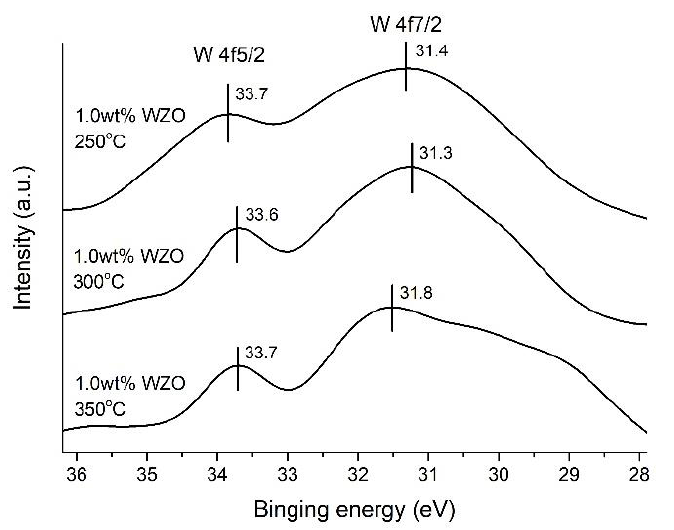
Figure 15. W 4f5/2 and W 4f/2 peak intensities of 1.0 wt.% WZO films grown at 250 °C, 300 °C, and 350 °C.